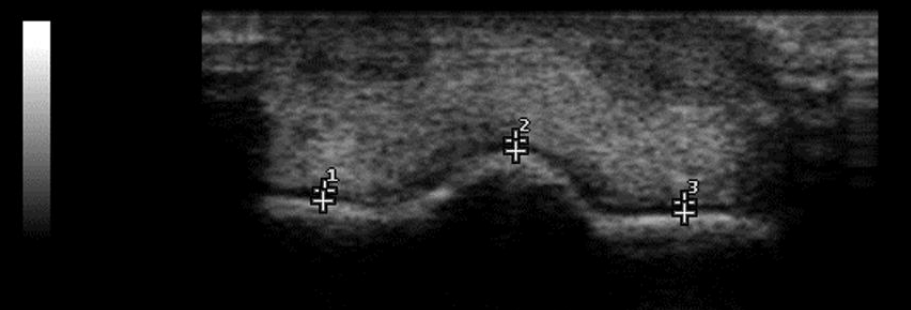
Figure 2. Transversal ultrasound view of thoroughbred MCP joint. (1) Lateral condyle, (2) sagittal ridge and (3) medial condyle. Lateral is to the left. B-mode, linear probe, 7.5 MHz.